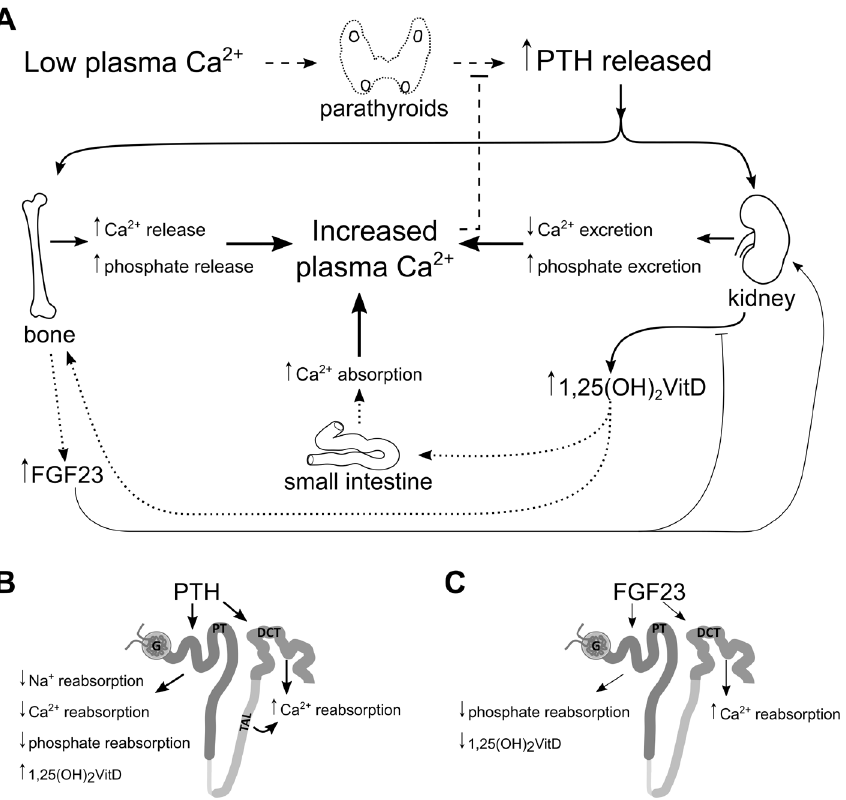
Figure 1. Regulation of calcium and phosphate by parathyroid hormone (PTH), 1,25-dihydroxyvitamin D (active vitamin D), and 3 fibroblast growth factor 23 (FGF23). ( A ) Low plasma calcium stimulates release of PTH from the parathyroid glands. PTH stimulates resorption of bone, releasing calcium and phosphate into the plasma. In the kidney, PTH increases urinary calcium reabsorption and phosphate excretion. ( B ) PTH-dependent active calcium reabsorption takes place in the distal nephron but, in the proximal tubule (PT), stimulates 1 α -hydroxylase to convert 25-hydroxyvitamin D into active vitamin D and reduces the reabsorption of sodium, calcium, and 3 phosphate. Active vitamin D increases calcium absorption from the small intestine and stimulates FGF23 secretion from bone. ( C ) FGF23 acts as a negative feedback modulator of activated vitamin D activation and increases distal nephron calcium reabsorption while decreasing phosphate reabsorption from